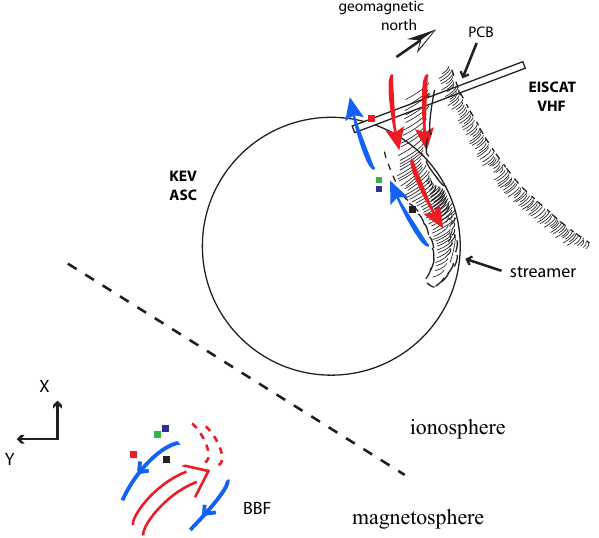
Fig. 11. Same as Fig. 9 for ∼ 18:42–18:45UT when C1 sees the duskside return flow of BBF 3a (see also Fig.